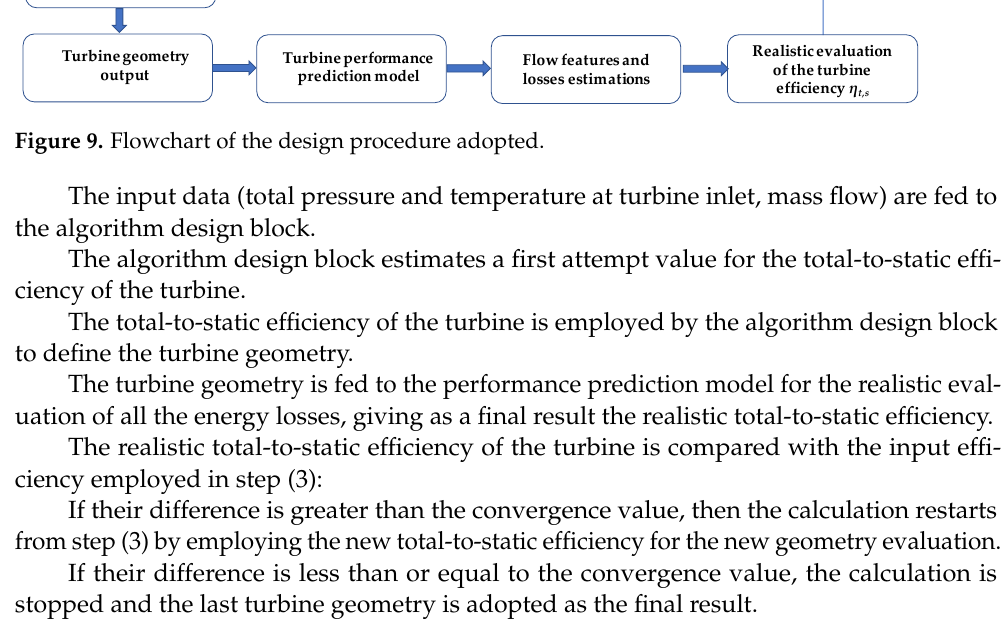
Figure 9. Flowchart of the design procedure adopted.